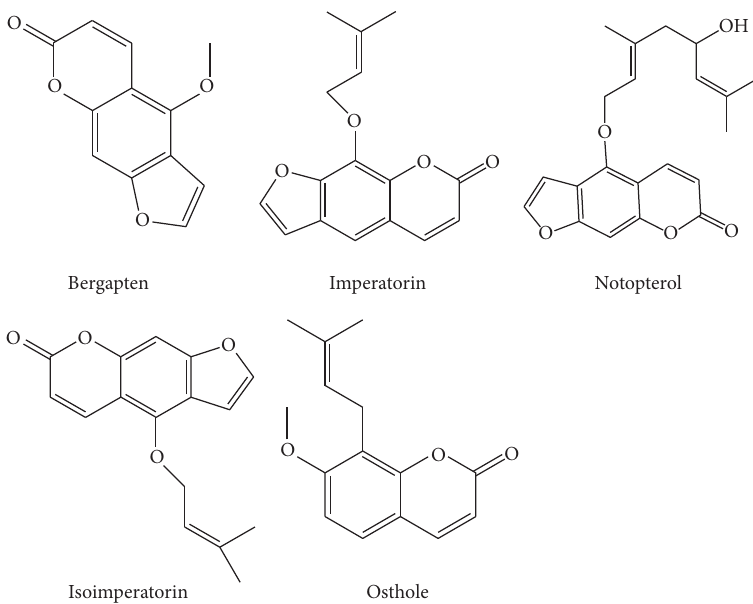
Figure 1: Chemical structures of bergapten, imperatorin, notopterol, osthole (IS), and